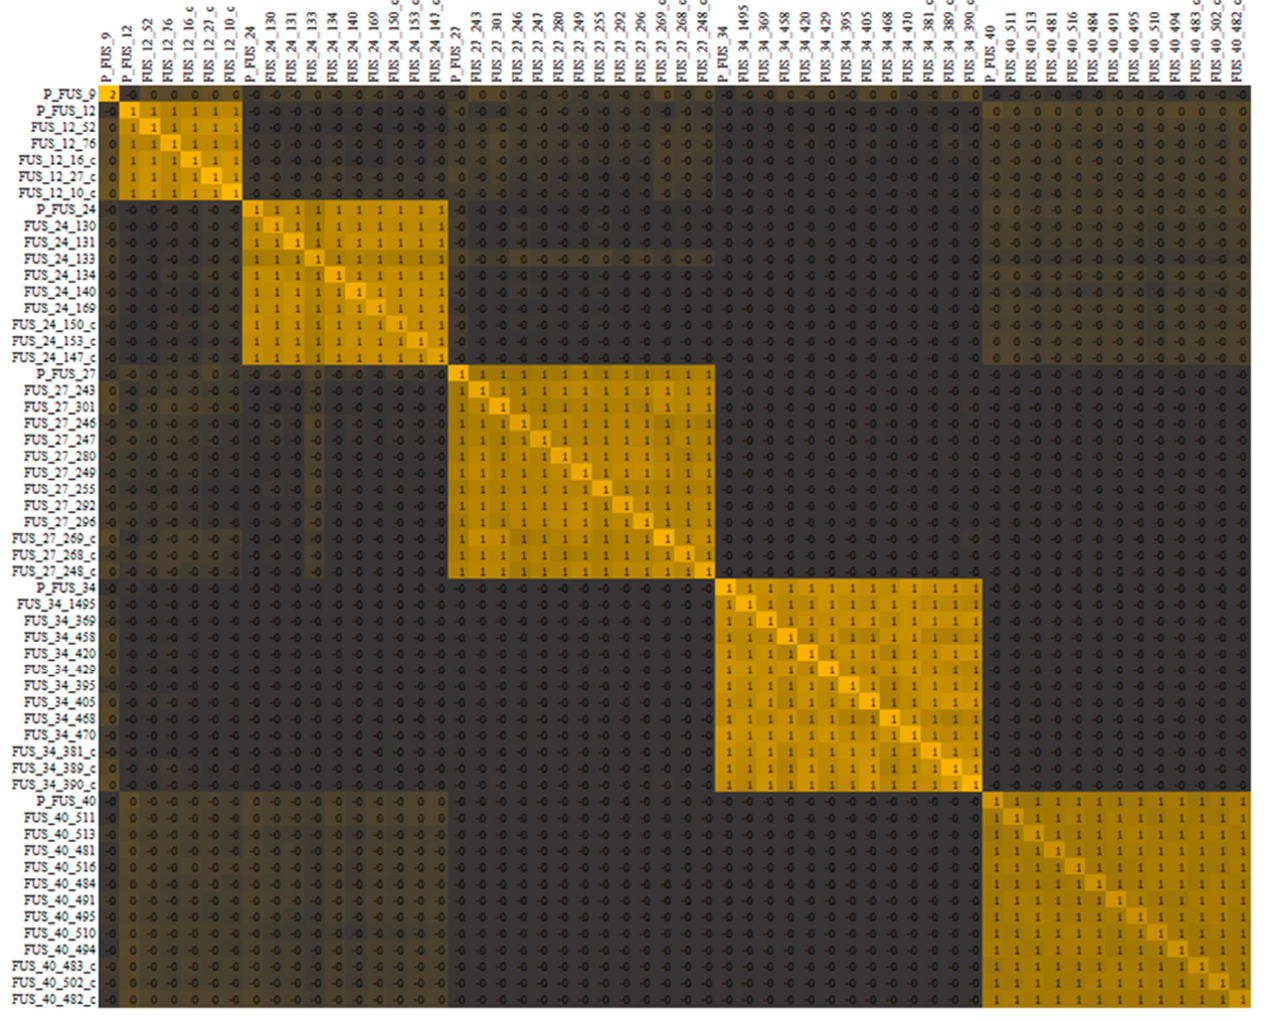
Figure 2. Heatmap of cluster analysis using kinship similarity matrix of 58 wheat genotypes based on DArT-SNP markers.